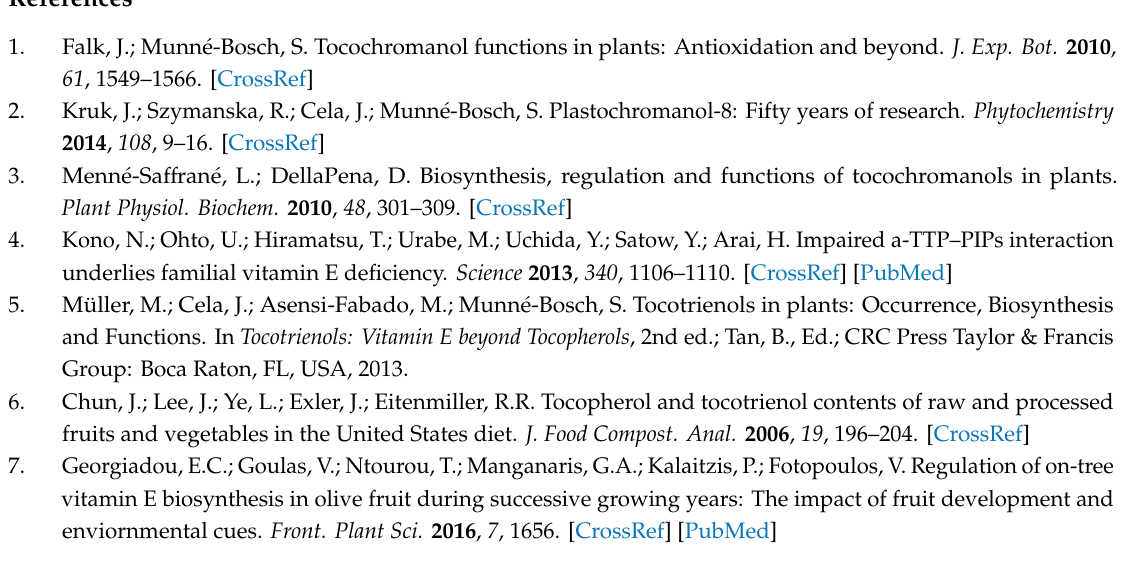
Figure S1: Variations in the contents of tocochromanols during long-term (10 d) storage of “Bacon” avocados at cold temperatures (4 ◦ C), Figure S2: Variations in the contents of chlorophylls, chlorophyll a / b ratio and the extent of l í pid peroxidation (estimated as the contents of l í pid hydroperoxides and malondialdehyde, as indicators of primary and secondary l í pid peroxidation, respectively) during long-term (10 d) storage of “Bacon” avocados at cold temperatures (4 ◦